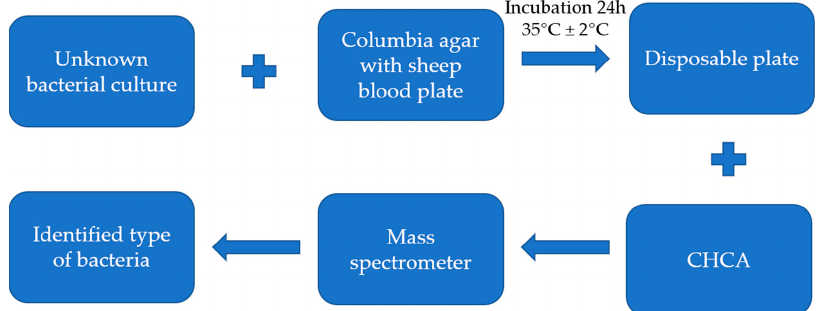
Figure 2. Process of identifying the type of bacteria.